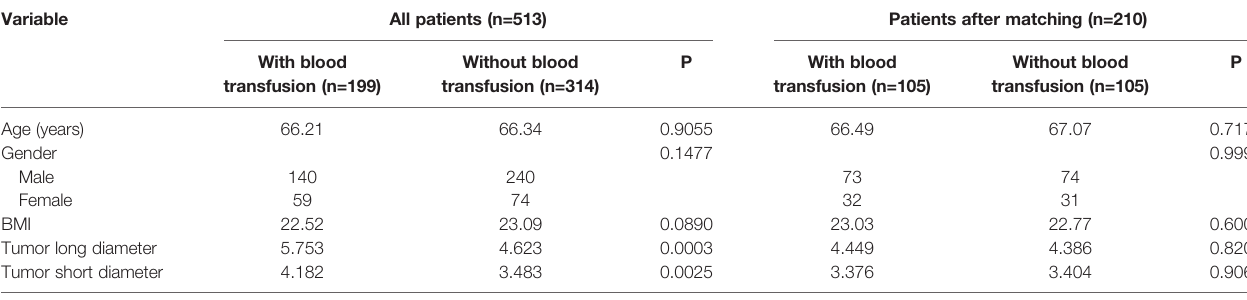
TABLE 2 | Short-term outcomes of patients who had total gastrectomy (TG) before and after propensity score matching (PSM). Variable